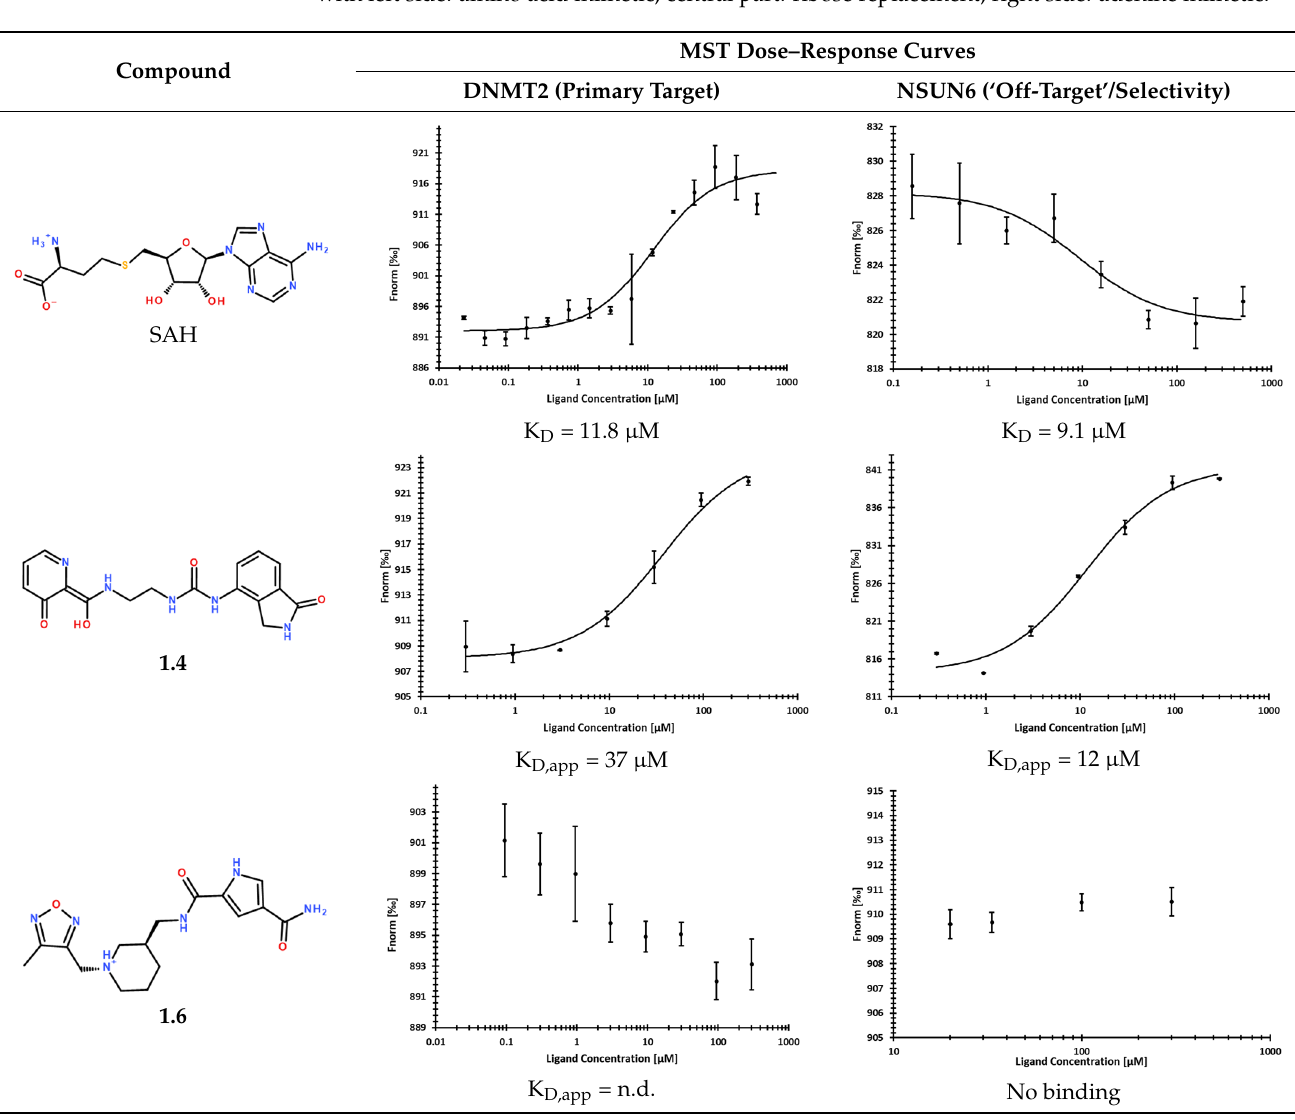
Table 2. MST results of SAH and newly identified DNMT2-ligands derived from the DNMT2 virtual screening. Measured normalized fluorescence values (Fnorm [‰]) are mean with standard error of at least duplicate determination. Apparent K D values (K D,app ) are indicated as a lower limit (via the at least duplicate determination. Apparent K D values (K D,app ) are indicated as a lower limit (via at least duplicate determination. Apparent K D values (K D,app ) are indicated as a lower limit (via the at least duplicate determination. Apparent K D values (K D,app ) are indicated as a lower limit (via the at least duplicate determination. Apparent K D values (K D,app ) are indicated as a lower limit (via the at least duplicate determination. Apparent K D values (K D,app ) are indicated as a lower limit (via the ≥ symbol) if the upper plateau of the dose–response curve was not completely reached. In case a at least duplicate determination. Apparent K D values (K D,app ) are indicated as a lower limit (via the at least duplicate determination. Apparent K D values (K D,app ) are indicated as a lower limit (via the at least duplicate determination. Apparent K D values (K D,app ) are indicated as a lower limit (via the ≥ symbol) if the upper plateau of the dose–response curve was not completely reached. In case a ≥ symbol) if the upper plateau of the dose–response curve was not completely reached. In case a ≥ symbol) if the upper plateau of the dose–response curve was not completely reached. In case a ≥ symbol) if the upper plateau of the dose–response curve was not completely reached. In case a dose-dependent shift in thermophoresis was observed, which indicates binding, but the curve could ≥ symbol) if the upper plateau of the dose–response curve was not completely reached. In case a ≥ symbol) if the upper plateau of the dose–response curve was not completely reached. In case a ≥ symbol) if the upper plateau of the dose–response curve was not completely reached. In case a dose-dependent shift in thermophoresis was observed, which indicates binding, but the curve could dose-dependent shift in thermophoresis was observed, which indicates binding, but the curve could dose-dependent shift in thermophoresis was observed, which indicates binding, but the curve could dose-dependent shift in thermophoresis was observed, which indicates binding, but the curve could dose-dependent shift in thermophoresis was observed, which indicates binding, but the curve could not be fitted with sufficient accuracy ( 1.6 , 1.17 , 1.18 ), K D,app was not determined (n.d.). Molecules are dose-dependent shift in thermophoresis was observed, which indicates binding, but the curve could dose-dependent shift in thermophoresis was observed, which indicates binding, but the curve could not be fi tt ed with su ffi cient accuracy ( 1.6 , 1.17 , 1.18 ), K D,app was not determined (n.d.). Molecules are not be fi tt ed with su ffi cient accuracy ( 1.6 , 1.17 , 1.18 ), K D,app was not determined (n.d.). Molecules are not be fi tt ed with su ffi cient accuracy ( 1.6 , 1.17 , 1.18 ), K D,app was not determined (n.d.). Molecules are not be fi tt ed with su ffi cient accuracy ( 1.6 , 1.17 , 1.18 ), K D,app was not determined (n.d.). Molecules are not be fi tt ed with su ffi cient accuracy ( 1.6 , 1.17 , 1.18 ), K D,app was not determined (n.d.). Molecules are not be fi tt ed with su ffi cient accuracy ( 1.6 , 1.17 , 1.18 ), K D,app was not determined (n.d.). Molecules are not be fi tt ed with su ffi cient accuracy ( 1.6 , 1.17 , 1.18 ), K D,app was not determined (n.d.). Molecules are depicted in their docked stereoisomers, protomers, and tautomers; however, for 1.6 , 1.17 , and 1.18 , depicted in their docked stereoisomers, protomers, and tautomers; however, for 1.6 , 1.17 , and 1.18 , depicted in their docked stereoisomers, protomers, and tautomers; however, for 1.6 , 1.17 , and 1.18 , depicted in their docked stereoisomers, protomers, and tautomers; however, for 1.6 , 1.17 , and 1.18 , depicted in their docked stereoisomers, protomers, and tautomers; however, for 1.6 , 1.17 , and 1.18 , depicted in their docked stereoisomers, protomers, and tautomers; however, for 1.6 , 1.17 , and 1.18 , depicted in their docked stereoisomers, protomers, and tautomers; however, for 1.6 , 1.17 , and 1.18 , depicted in their docked stereoisomers, protomers, and tautomers; however, for 1.6 , 1.17 , and 1.18 , racemic mixtures were obtained for testing. All molecules are drawn in the same orientation as SAH, racemic mixtures were obtained for testing. All molecules are drawn in the same orientation as SAH, racemic mixtures were obtained for testing. All molecules are drawn in the same orientation as SAH, racemic mixtures were obtained for testing. All molecules are drawn in the same orientation as SAH, racemic mixtures were obtained for testing. All molecules are drawn in the same orientation as SAH, racemic mixtures were obtained for testing. All molecules are drawn in the same orientation as SAH, racemic mixtures were obtained for testing. All molecules are drawn in the same orientation as SAH, racemic mixtures were obtained for testing. All molecules are drawn in the same orientation as SAH, with left side: amino acid mimetic, central part: ribose replacement, right side: adenine mimetic. with left side: amino acid mimetic, central part: ribose replacement, right side: adenine mimetic. with left side: amino acid mimetic, central part: ribose replacement, right side: adenine mimetic. with left side: amino acid mimetic, central part: ribose replacement, right side: adenine mimetic. with left side: amino acid mimetic, central part: ribose replacement, right side: adenine mimetic. with left side: amino acid mimetic, central part: ribose replacement, right side: adenine mimetic. with left side: amino acid mimetic, central part: ribose replacement, right side: adenine mimetic. with left side: amino acid mimetic, central part: ribose replacement, right side: adenine mimetic. MST Dose–Response Curves MST Dose–Response Curves MST Dose–Response Curves MST Dose–Response Curves MST Dose–Response Curves MST Dose–Response Curves Compound MST Dose–Response Curves MST Dose–Response Curves Compound Compound Compound Compound Compound Compound Compound DNMT2 (Primary Target) DNMT2 (Primary Target) NSUN6 (‘O ff -Target’/Selectivity) DNMT2 (Primary Target) NSUN6 (‘O ff -Target’/Selectivity) DNMT2 (Primary Target) NSUN6 (‘Off-Target’/Selectivity)